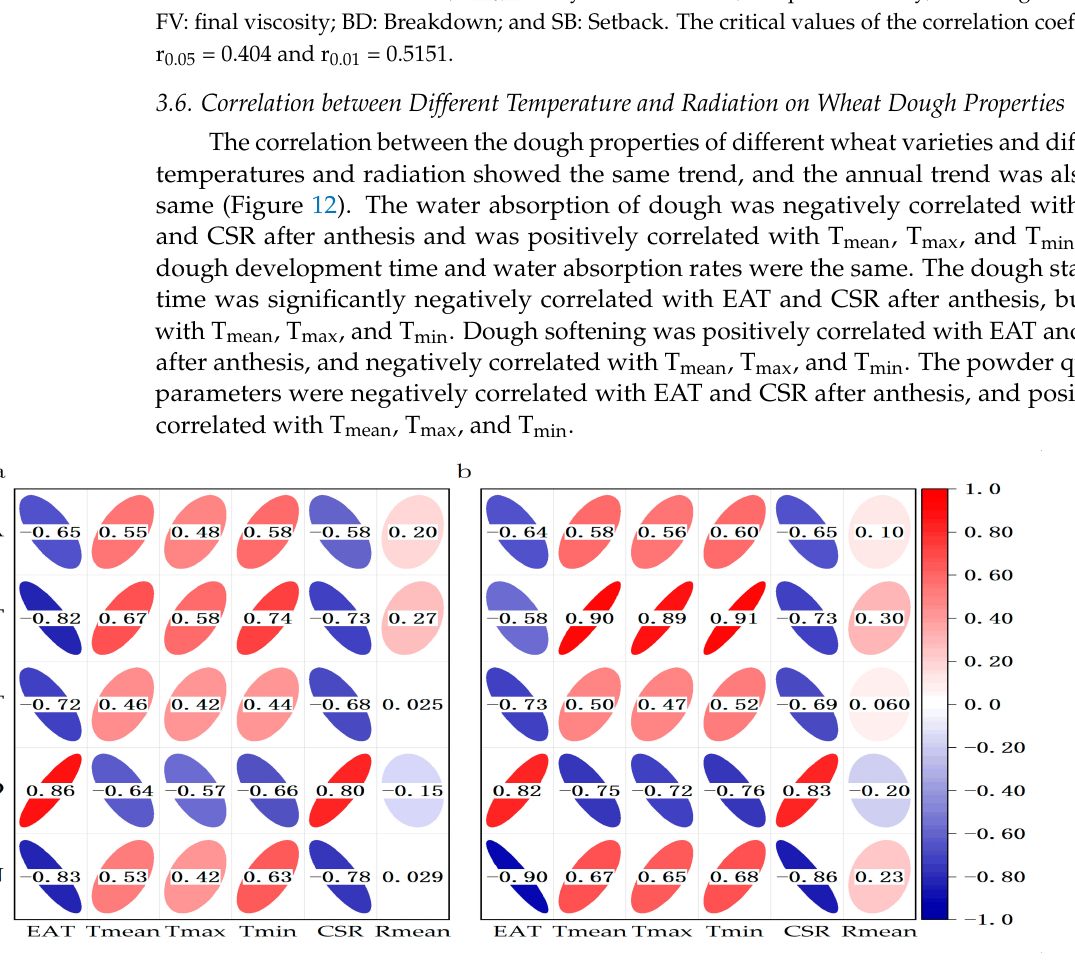
Figure 12. Correlation of different post-anthesis temperatures and radiation on dough properties of wheat. ( a ): 2017–2018, ( b ): 2018–2019; EAT: effective accumulated temperature, T mean : daily